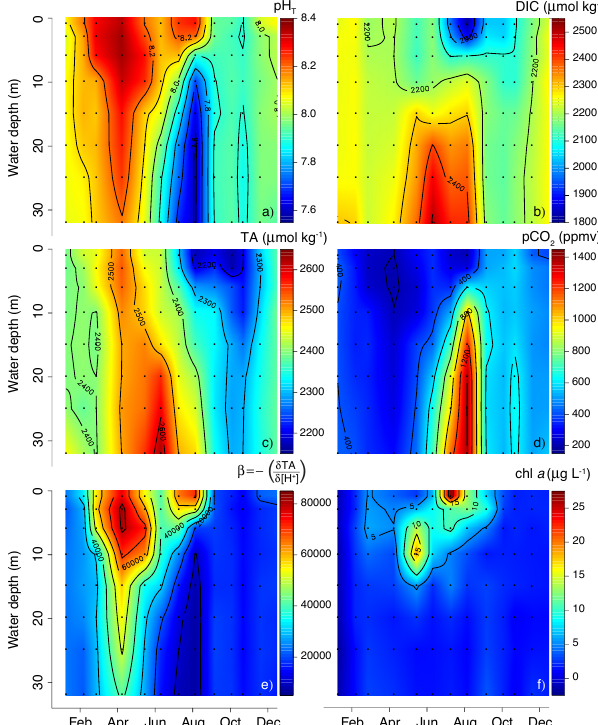
Figure 4. (a) pH T (at in situ temperature), (b) DIC (µmolkg − 1 ), (c) TA (µmolkg − 1 ), (d) p CO 2 (ppmv), (e) buffering capacity ( β ) and (f) concentration of Chl a (µgL − 1 ) at Den Osse in 2012. Black dots indicate sampling intervals. TA and p CO 2 were calculated from measured pH T and DIC using the equilibrium constants of Mehrbach et al. (1973) as refitted by Dickson and Millero (1987), while β was calculated from measured pH T and calculated TA. All data were linearly interpolated in space and